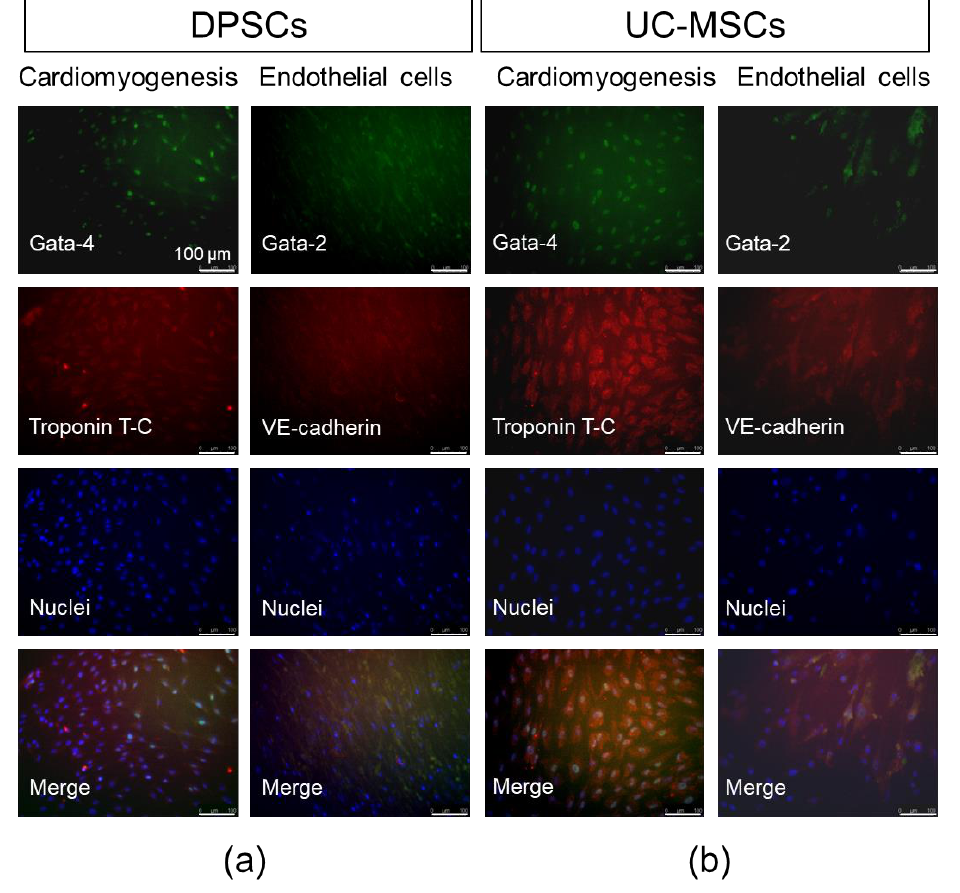
Figure 6. Cardiomyogenic and endothelial differentiation of DPSCs and UC-MSCs in vitro on day 7. ( a ) Representative images of cardiomyogenic and endothelial marker expression in DPSCs. ( b ) Representative images of cardiomyogenic and endothelial marker expression in UC-MSCs. In the case of cardiomyogenic differentiation, cells were cultured in DMEM/F12 supplemented with 2% FBS and 10 ng/mL bFGF, 10 ng/mL VEGF and 10 ng/mL TGF-β1. On day 7, cells were fixed, permeabilized, and stained against intranuclear transcription factor Gata-4 (Alexa Fluor 488, green) and troponin T-C (Alexa Fluor 546, red), whereas nuclei were co-stained with DAPI (blue). In the case of endothelial differentiation, cells were cultured in EGM-2MV. On day 7, cells were fixed, permeabilized, and stained against intranuclear transcription factor Gata-2 (Alexa Fluor 488, green) and VE-cadherin (Alexa Fluor 546, red), whereas nuclei were co-stained with DAPI (blue). Cells were analysed with Leica DMI6000B ver. AF7000 fluorescent microscope. Scale bars: 100 μm.